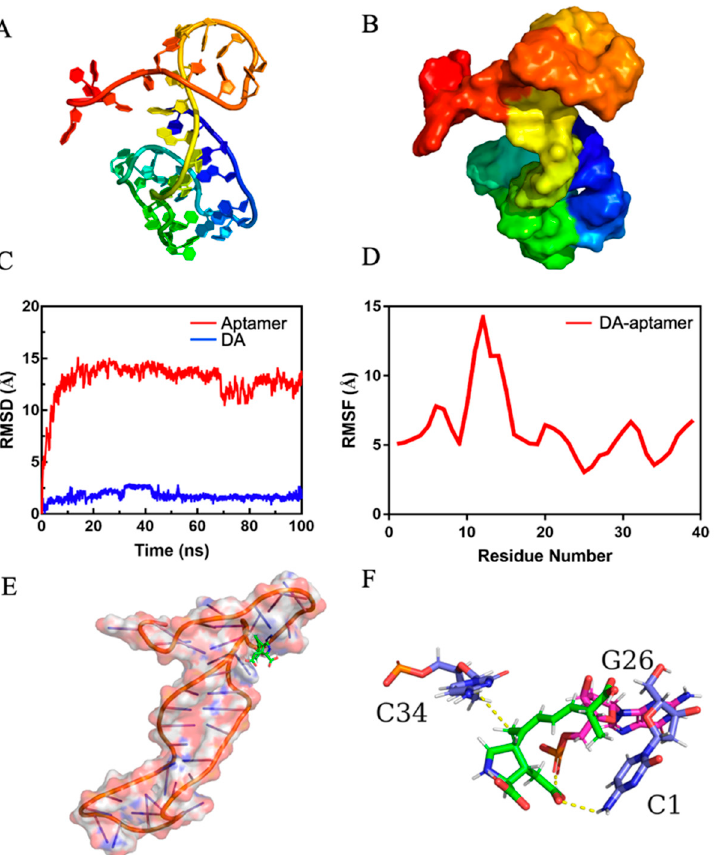
Figure 5. ( A ) Drawn view of C1-d 3D structure. ( B ) Surface view of C1-d 3D structure. ( C ) RMSD of DA–aptamer. ( D ) RMSF of DA–aptamer. ( E ) The binding model of DA–aptamer in the final stable structure. ( F ) The 3D binding mode of DA–aptamer. The aptamer was depicted as a cartoon and surface. The DA was colored green. The surrounding G was color in magenta and C was color in slate. The yellow dashed line shows hydrogen bonds.